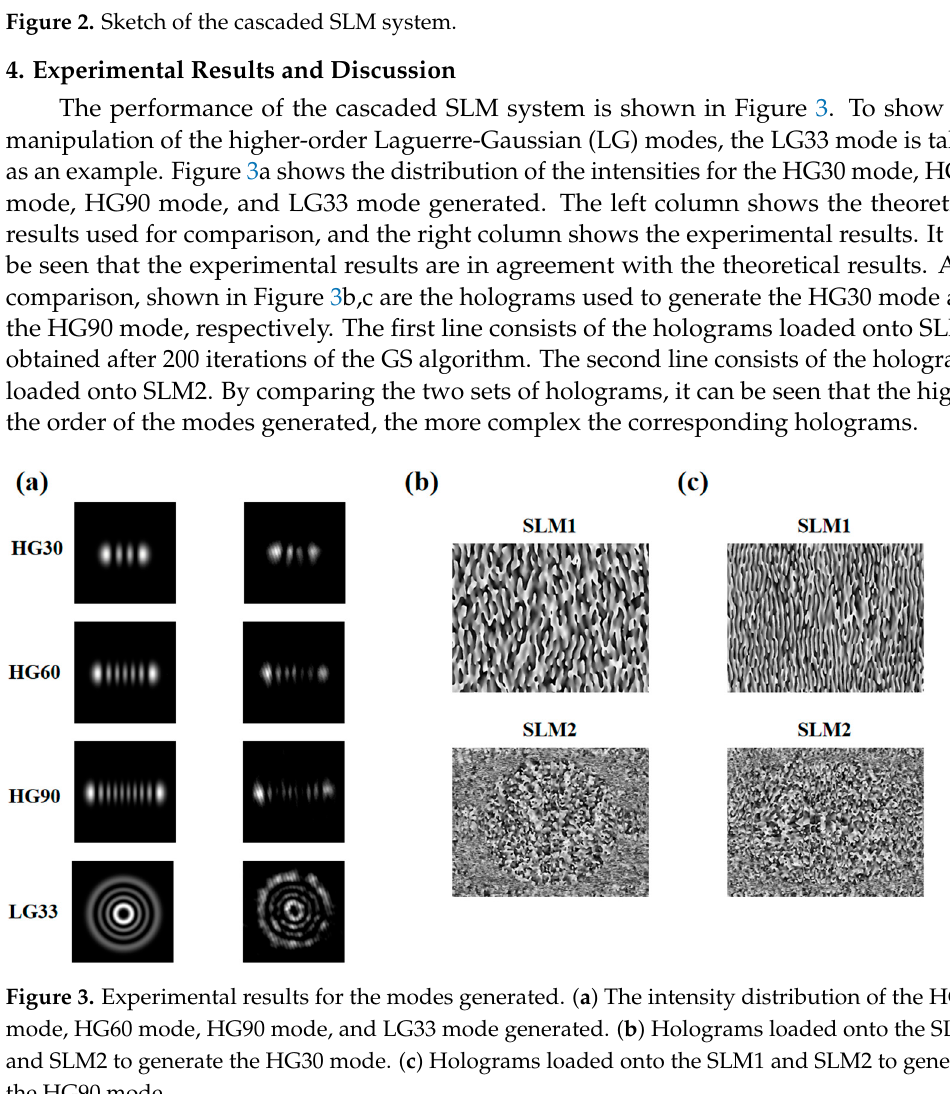
Figure 2. Sketch of the cascaded SLM system.